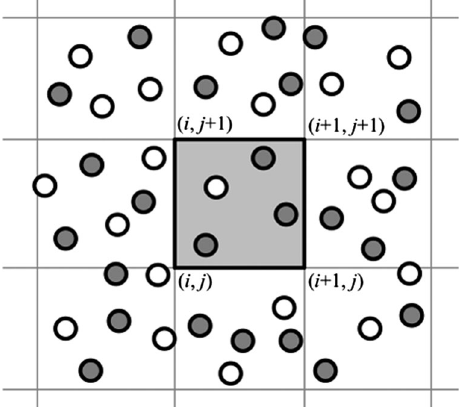
FIG. 1. Coarse-grained mesh. Illustration of point ions and coarse-grained mesh used to find the local ionization levels of the mixtures in each cell. Note that, in practice, the mesh and ion coordinates are in three dimensions, and the mesh spacings need not be equal in each